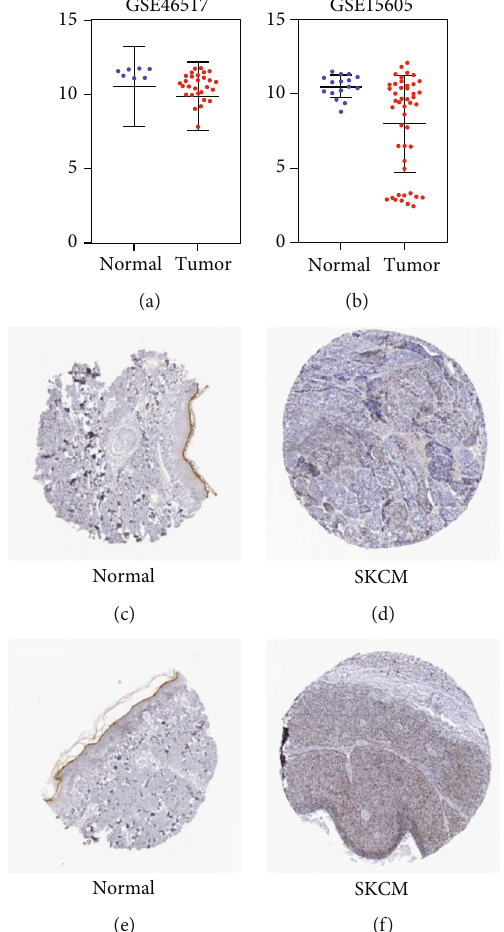
Figure 7: Results of external data validation: (a, b) FLG expression levels in normal and SKCM tissues, as obtained from GSE46517 and GSE15605; (c – f) immunohistochemical comparison of FLG in normal skin tissues and SKCM